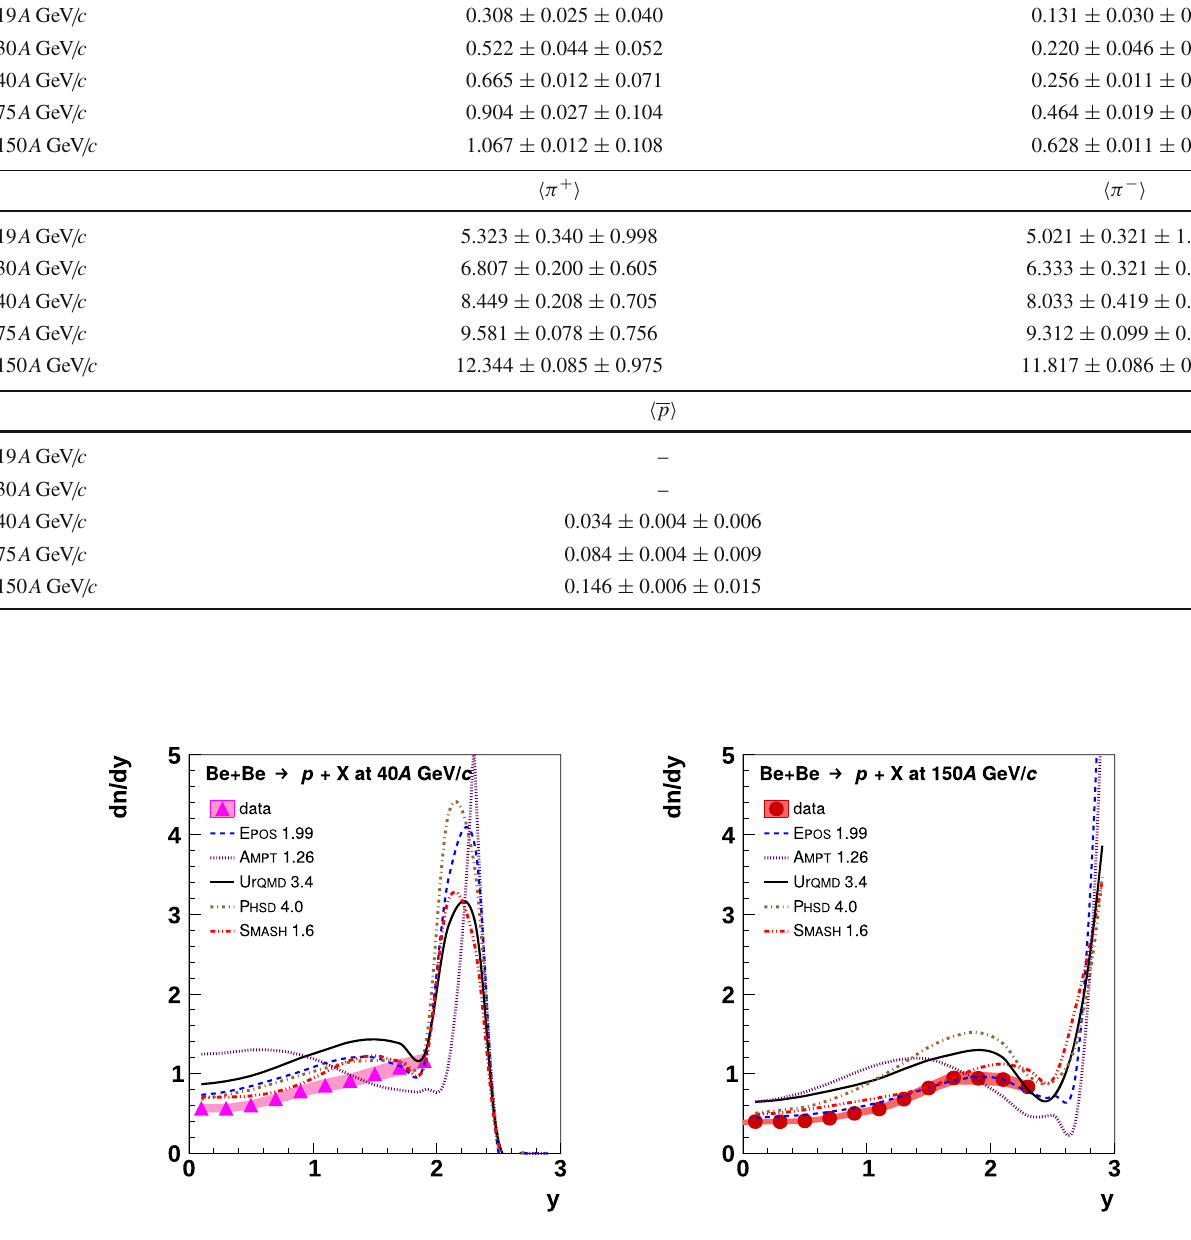
solid line), Ampt 1.26 [35–37] (violet dotted line), Phsd 4.0 [38,39] (brown dashed-dotted line) and Smash 1.6 (red dashed-double dotted line) [40,41]